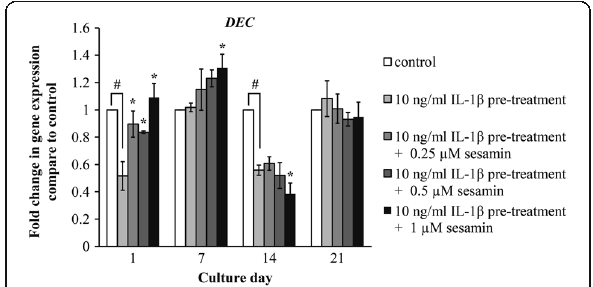
Fig. 5 The effects of sesamin on decorin gene expression in IL-1 β pre-treated HAC pellets. Data presented are the mean ± S.D. of three independent cultures. Statistical significance of the difference between IL-1 β pre-treatment alone and untreated (control): * = p < 0.05; between sesamin treatment and IL-1 β pre-treatment alone: # = p <